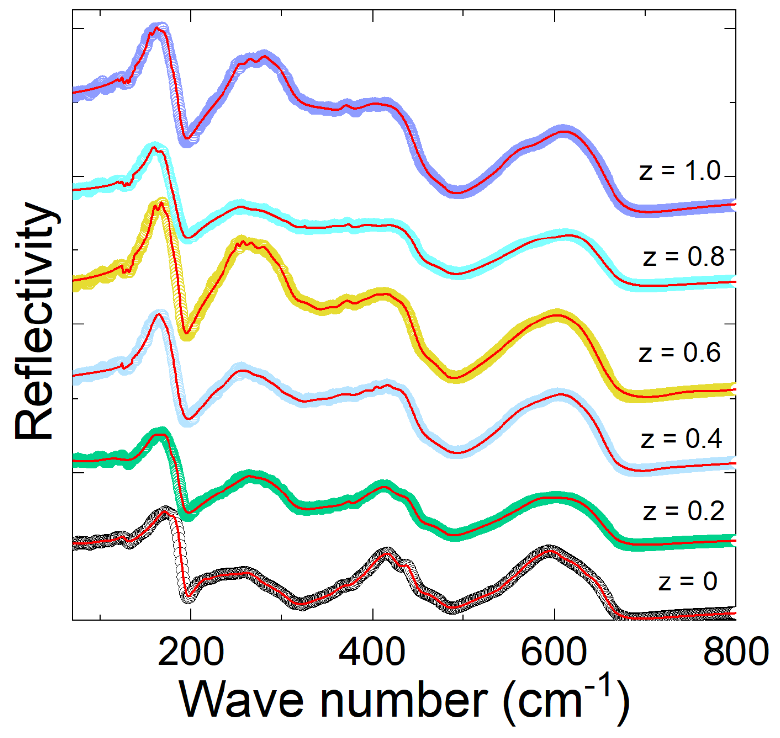
Figure 3. IR spectra of La 2 Co 1 − z Fe z MnO 6 (z = 0, 0.2 – 1.0) at room temperature: red line displays experimental values and black circle represent the refined fitted data.